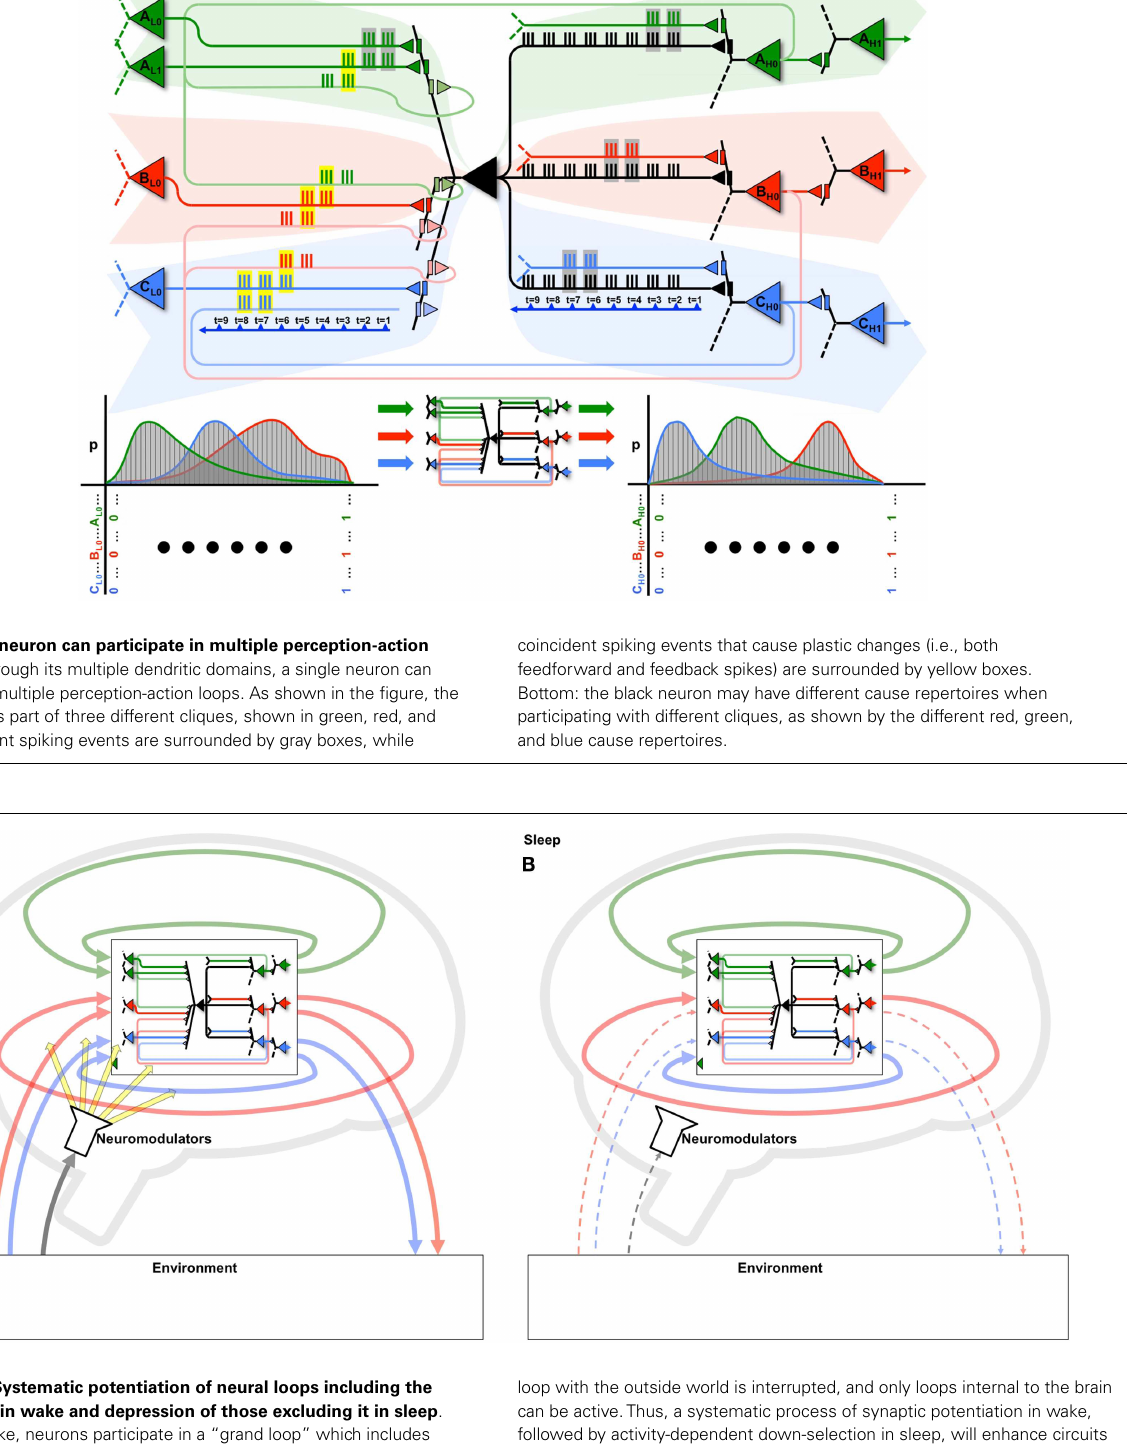
FIGURE 10 | Systematic potentiation of neural loops including the environment in wake and depression of those excluding it in sleep . (A) During wake, neurons participate in a “grand loop” which includes sensory input from and motor outputs to the outside world. During wake, synaptic potentiation leads to the formation of new memories by strengthening several perception-action loops. (B) During sleep, the grand